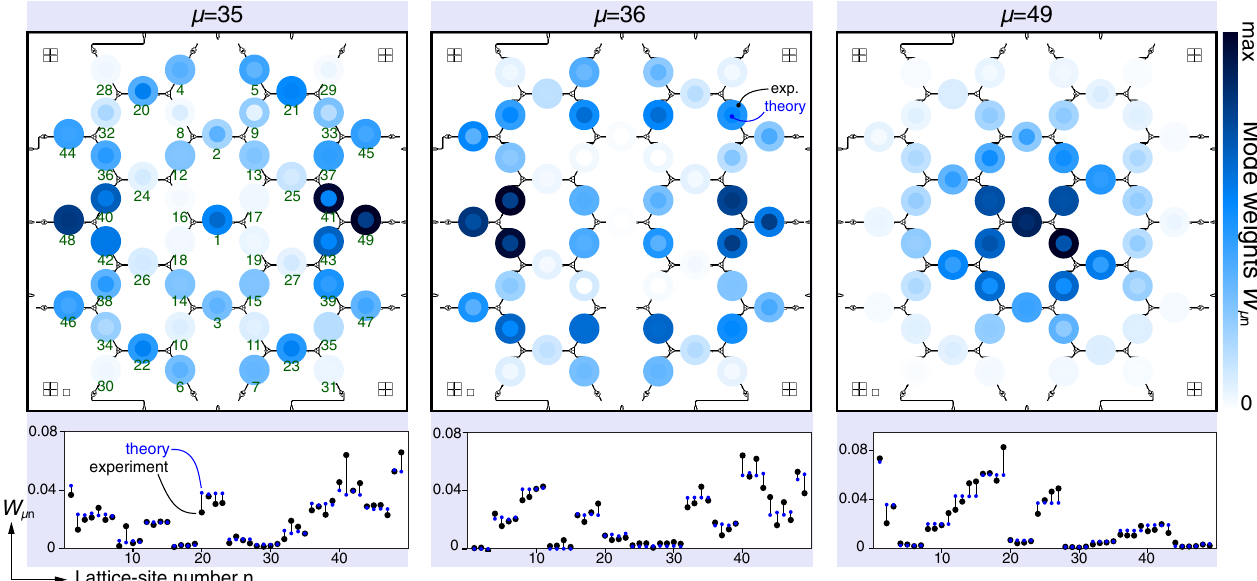
FIG. 5. Normal-mode weights for three select modes, μ ¼ 35 , 36, and 49. For each lattice site n , the mode weight W μ n ¼ jð n j μ Þj 2 is depicted as an overlay of two color-coded disks. Inner disks represent the theory prediction for the weights, the outer disks the weights determined experimentally by scanning defect microscopy. The bottom panels show deviations in normal-mode weights as lines connecting experimental data (black dots) and theory prediction (blue dots). Comparison shows good agreement with noticeable deviations in only a few sites in each